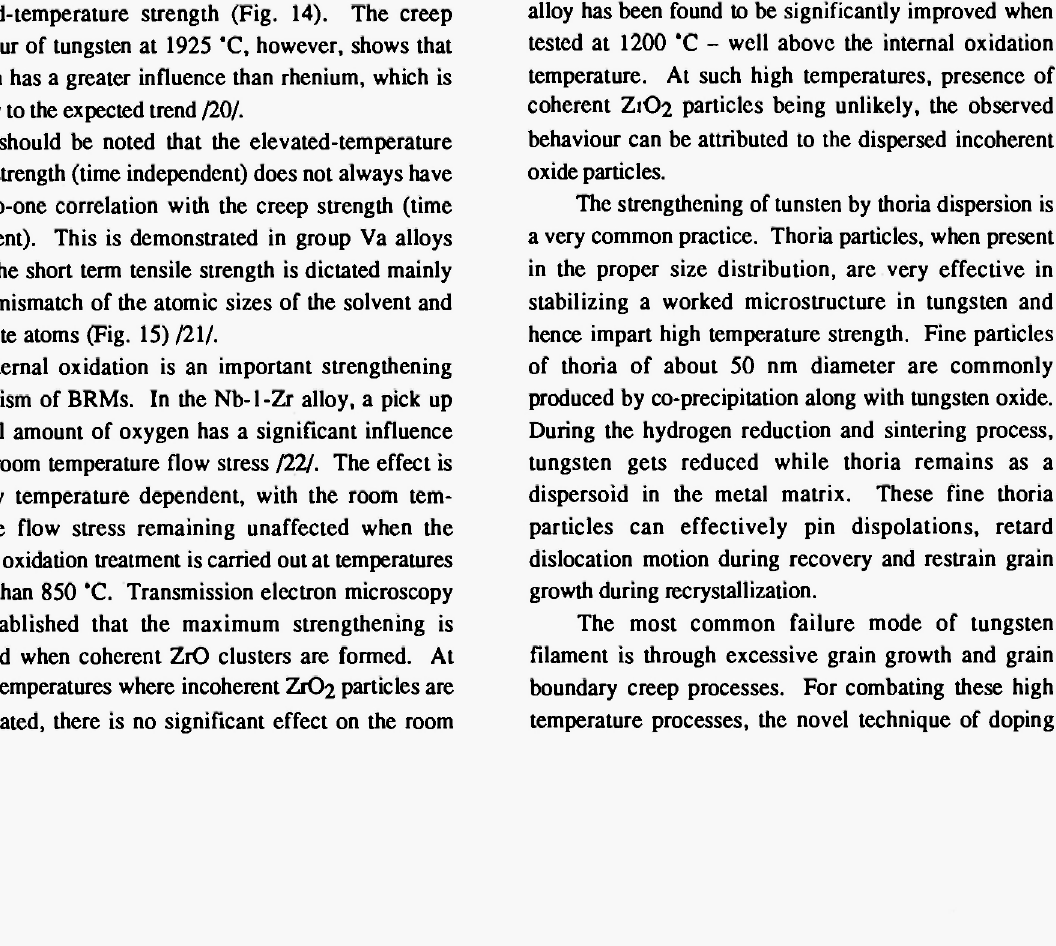
15: Correlation between atomic mismatch between solvent and solute atoms and the elevated temperature (1200 "C) tensile strength of niobium (from /21